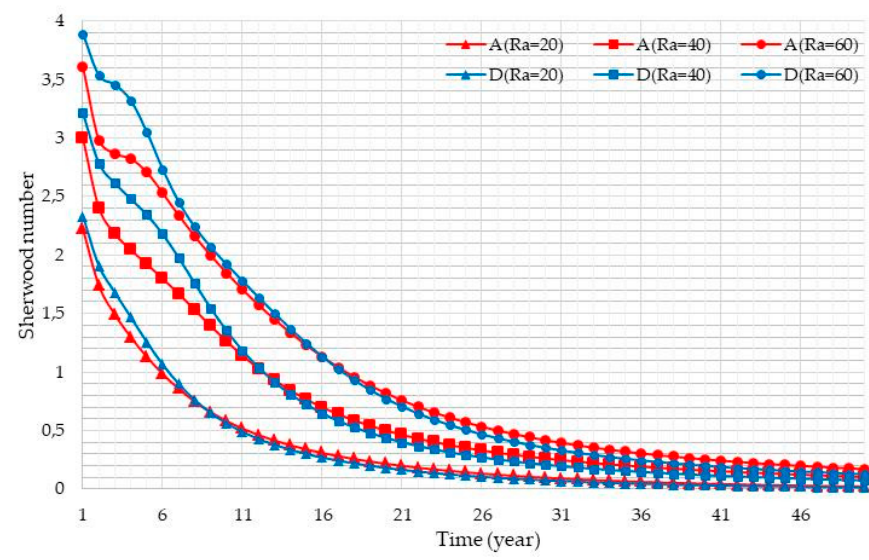
Figure 8. The local Sherwood number beneath the source zone in the top layer versus time for different Rayleigh numbers for scenarios A and D.